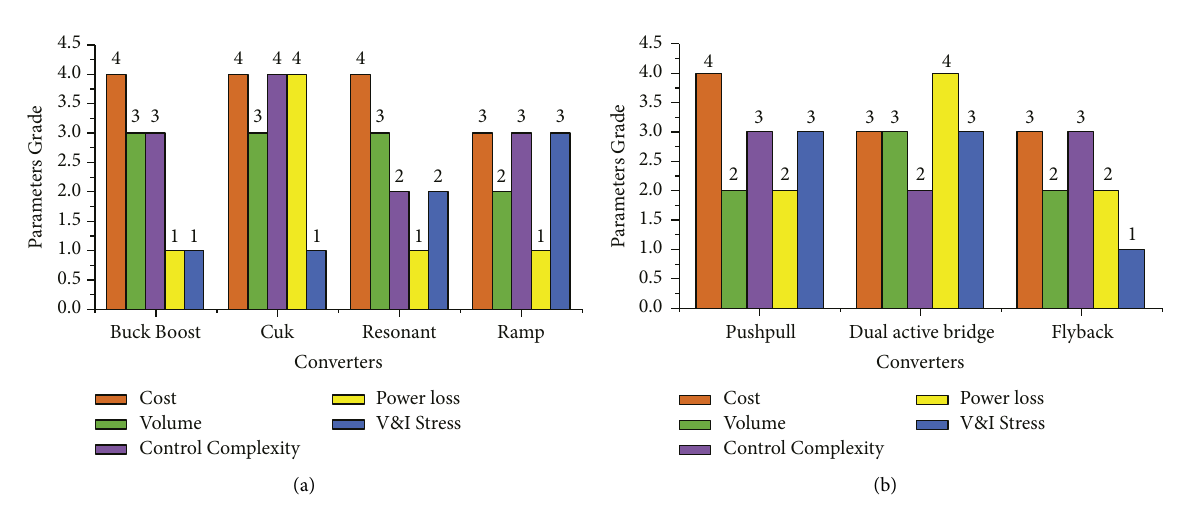
Figure 18: (a, b) Pictorial comparison of diferent converter topologies of BCE. Note: 1 is low, 2 is medium, 3 is high, and 4 is very high.